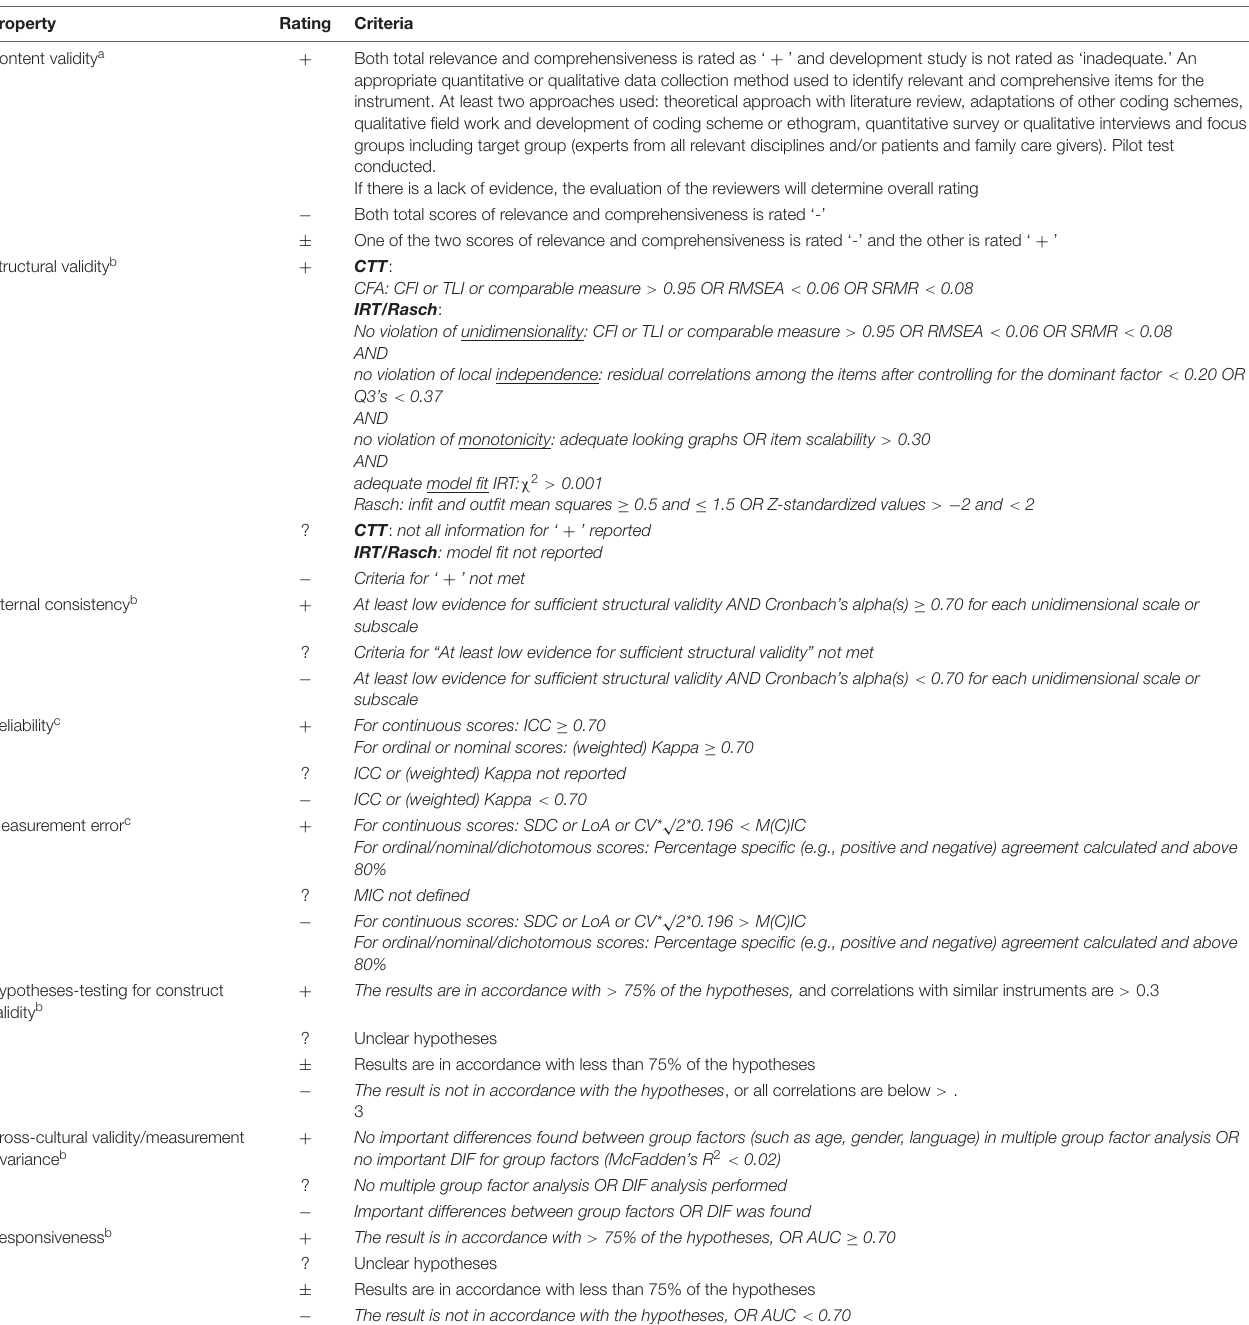
TABLE 2 | Adapted COnsensus-based Standards for the selection of health Measurement INstruments (COSMIN)-quality criteria.